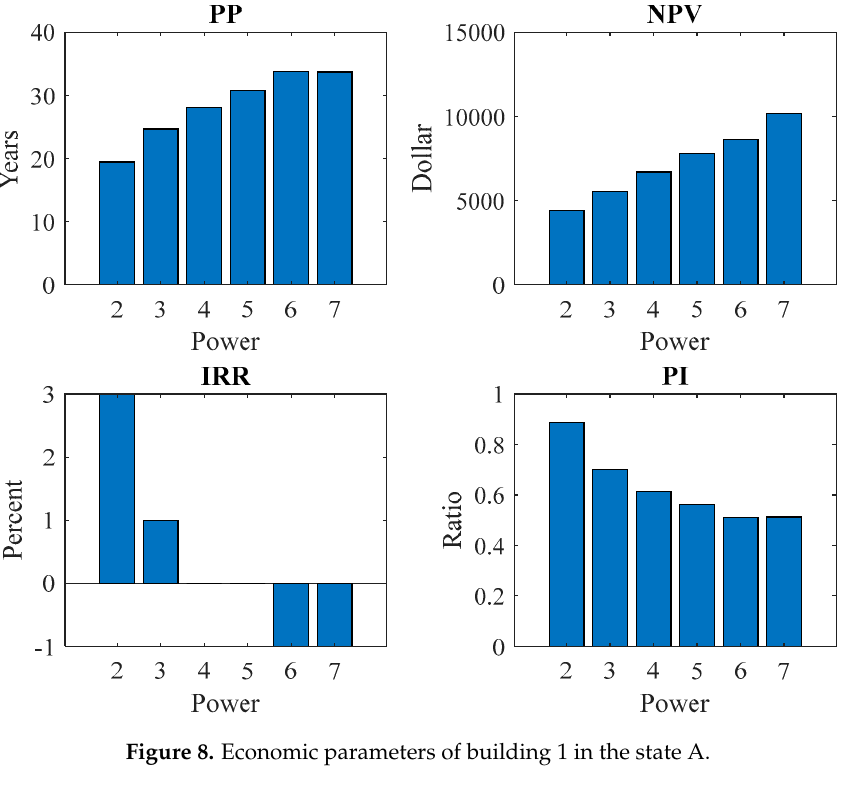
Energies 2018 , 11 , x FOR PEER REVIEW Figure 8. Economic parameters of building 1 in the state A. Figure 8. Economic parameters of building 1 in the state A.